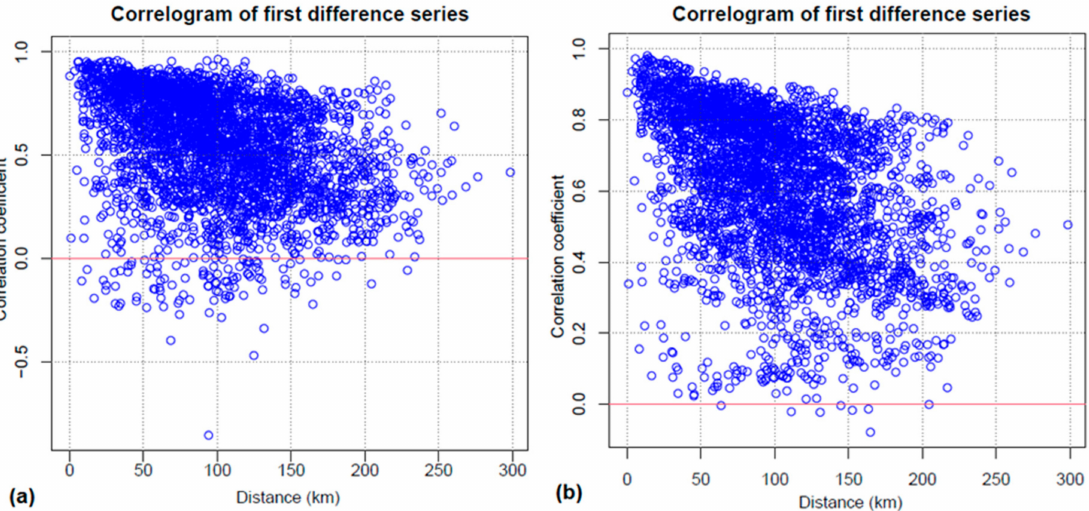
Figure 4. Correlograms of the first differences of the series stations ( a ) raw data and ( b ) adjusted data. The detection of breaks in the time series allowed the identification of 13